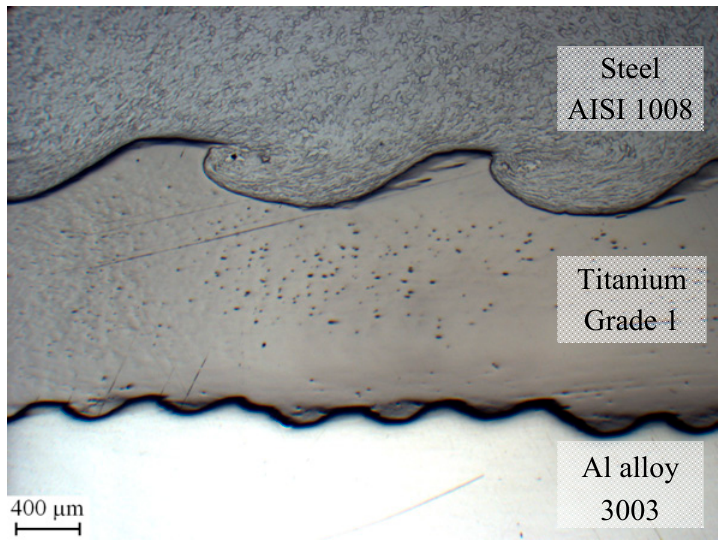
Figure 11. Cross section of an explosion welded joint between a steel and an aluminum alloy, with a titanium interlayer.